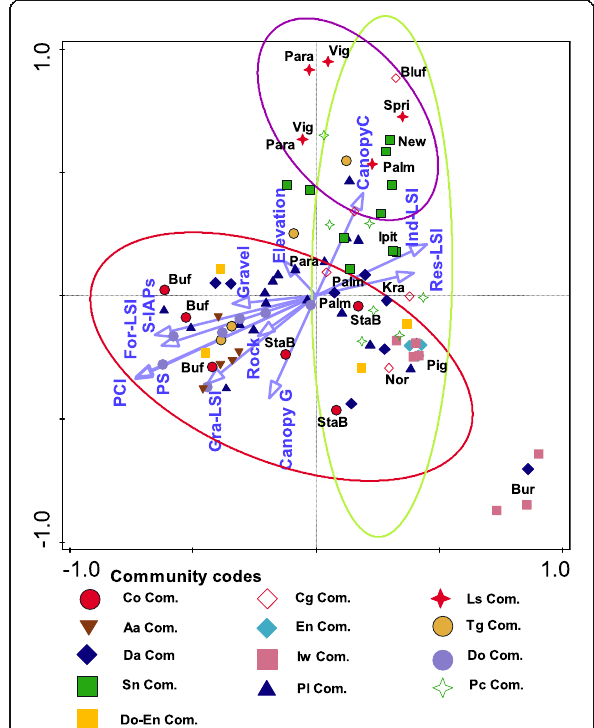
Fig. 7 Envelop mapping of the three important invasive species communities found in association with native species communities that occur in 15 forest patches found in the Durban Metropolitan Open Space System. Blue arrows and corresponding labels represent the environmental factors. Community codes are detailed in Table